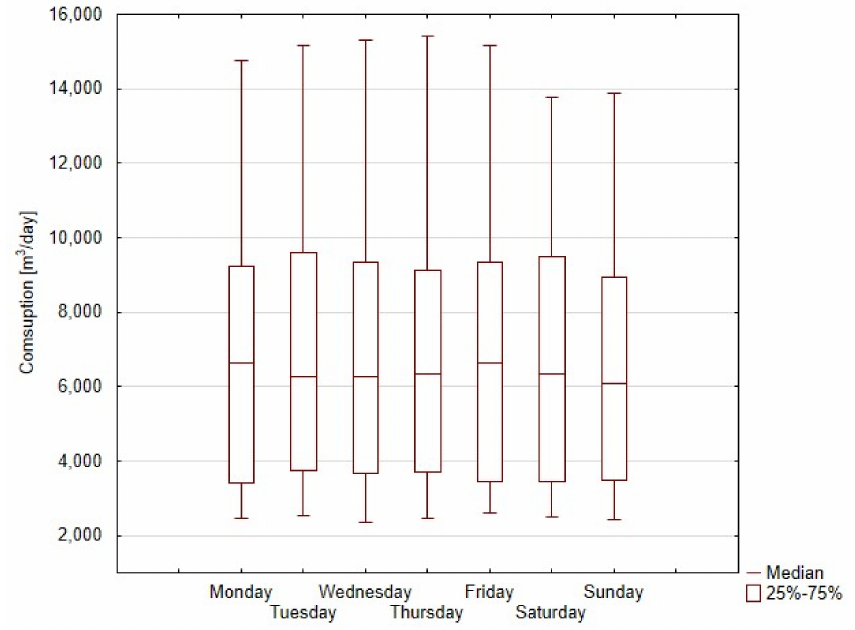
Figure 5. Average gas consumption on individual days of the week ( x -axis: natural gas consumption in m 3 /day (24